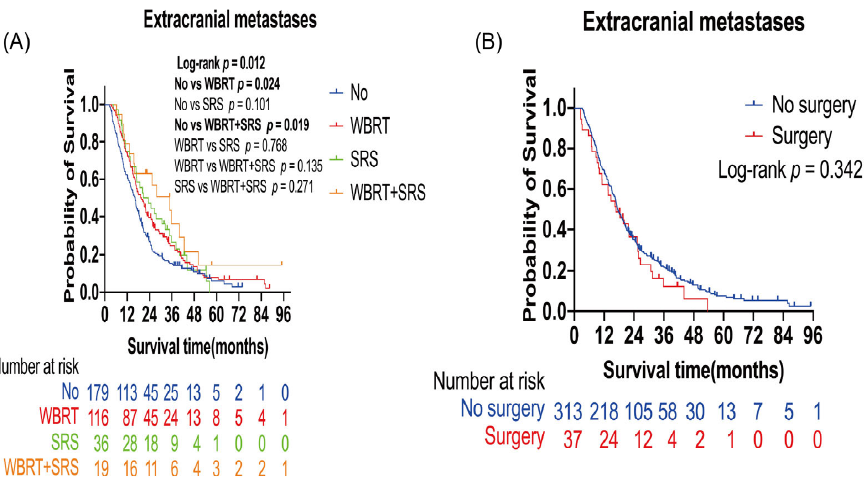
Figure 3. Kaplan–Meier overall survival curves of patients with lung cancer brain metastases with extracranial metastases: ( A ) Kaplan–Meier OS curves according to radiotherapy; ( B ) Kaplan–Meier OS curves according to surgery. Plot symbols at both events and censored cases. SRS, stereotactic radiosurgery; WBRT, whole brain radiotherapy. Table 4. Univariate and multivariate analyses of risk factors for OS in lung BMs patients with extra ‐ cranial metastases.